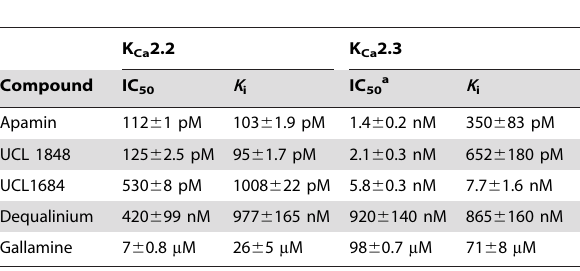
a Data from Hosseini et al . 2000, using CHO cells.